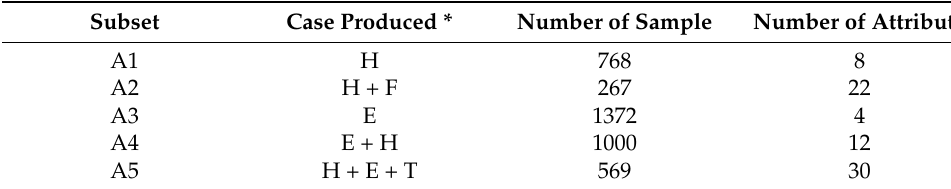
Table 3. Data set for a normal and abnormal state. Subset Case Produced * Number of Sample Number of Attribute A1 H 768 8 A2 267